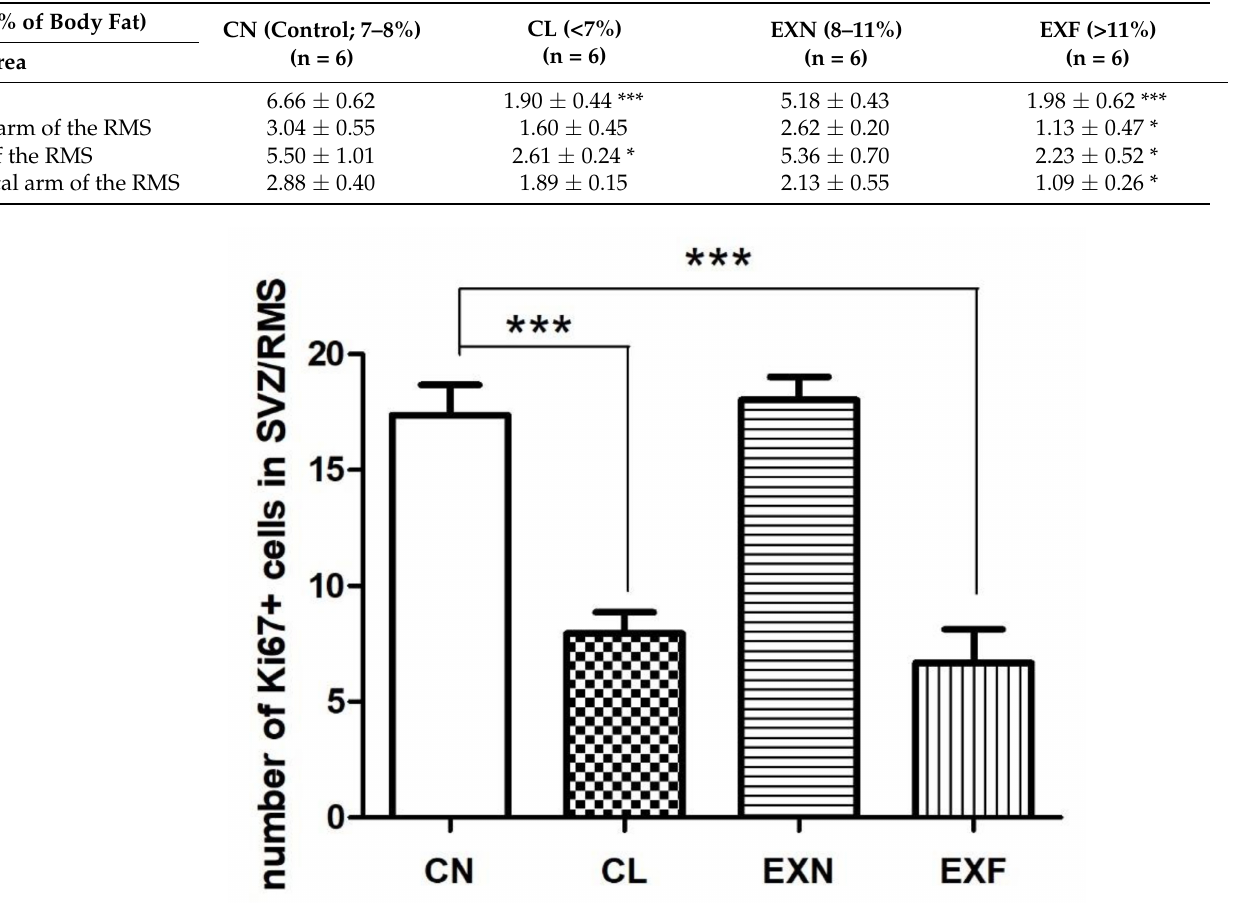
Table 2. The number of Ki-67+ cells in the SVZ/RMS neurogenic region (200 µ m × 200 µ m area) in mice with various body conditions. Abbreviations: SVZ—subventricular zone; RMS—rostral migratory stream; (CN) control group of mice characterized by normal weight and physiological percentage of body fat deposits; (CL) control group of mice characterized by reduced weight and